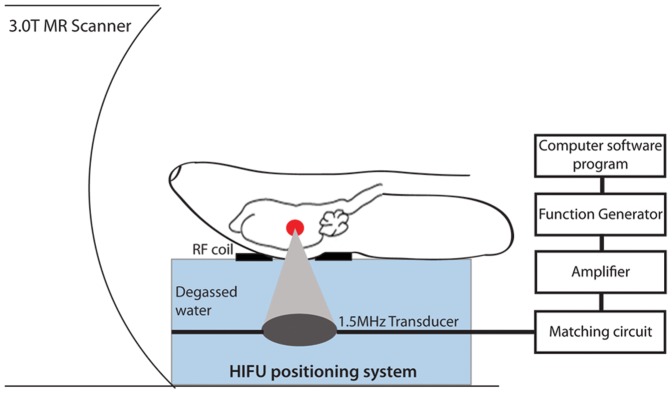
Schematic of experimental procedure.The rabbit is placed supine on a FUS positioning system and the head is coupled to the transducer with degassed water. The entire positioning system is placed inside the 3T MRI. The sonication is controlled by a computer software program which sets the function generator. The signal is amplified before reaching the matching circuit and transducer. Single point sonications are performed every 0.75 mm, moving distal to proximal and superior to inferior, to cover the entire clot surface.